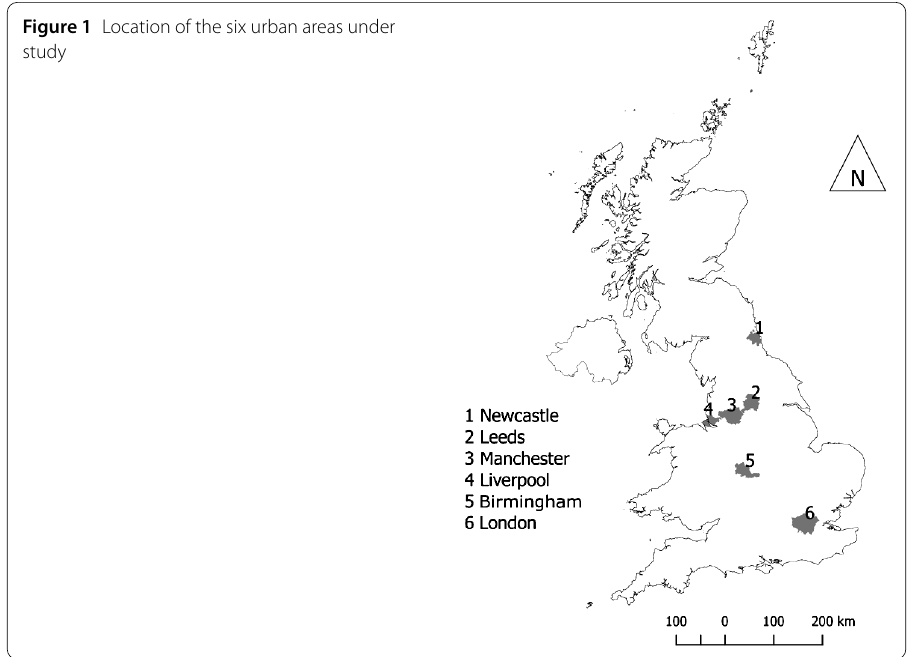
Figure 1 Location of the six urban areas under